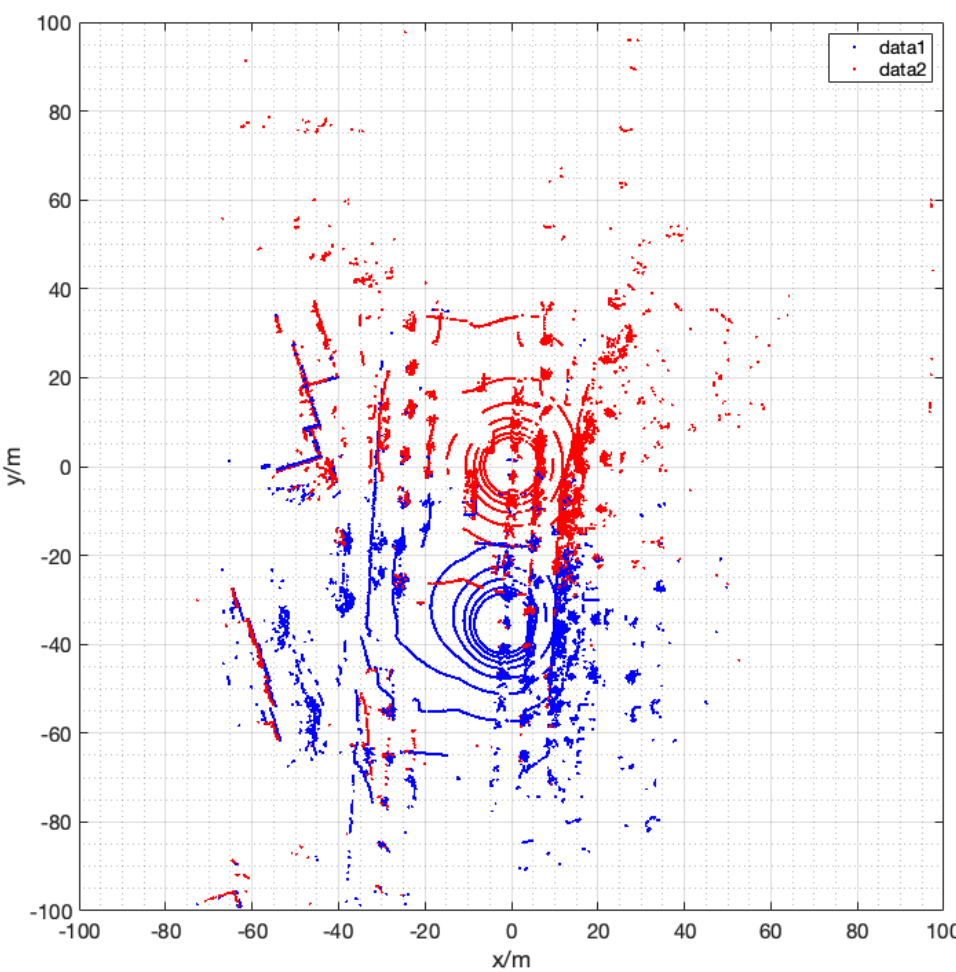
Figure 14. Result of registration in the roadside